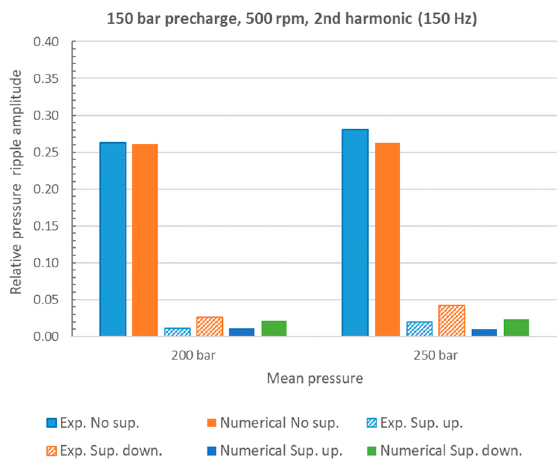
Figure 8. FFT of the pressure ripple, 2nd harmonic, pump speed = 500 rpm.